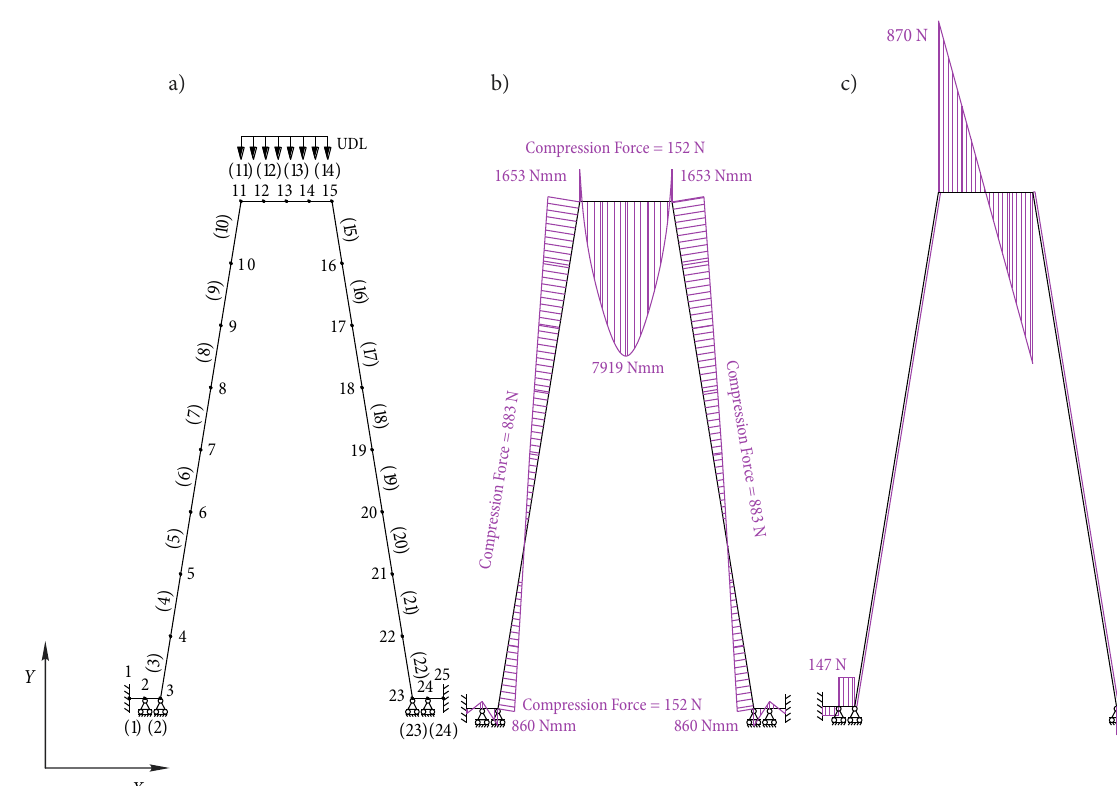
Fig. 2. (a) Schematic calculation model; (b) Bending moment diagram; (c) Axial and sheer force